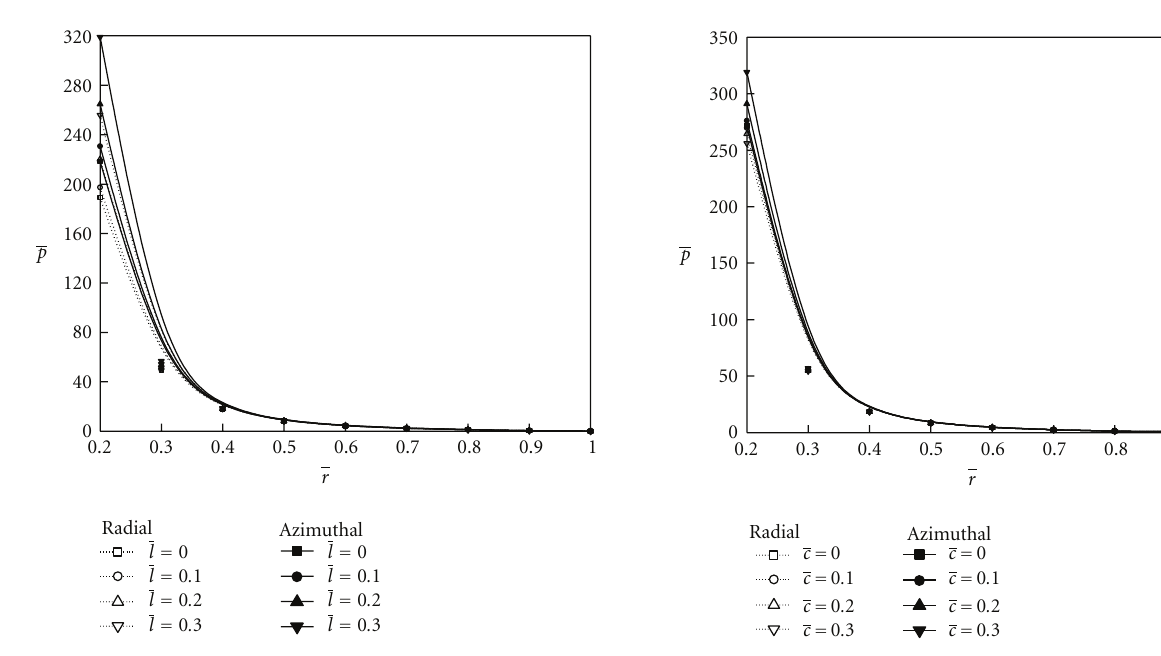
the parametric values β = 0 . 05, h m = 0 . 3, l = 0 . 3, c =